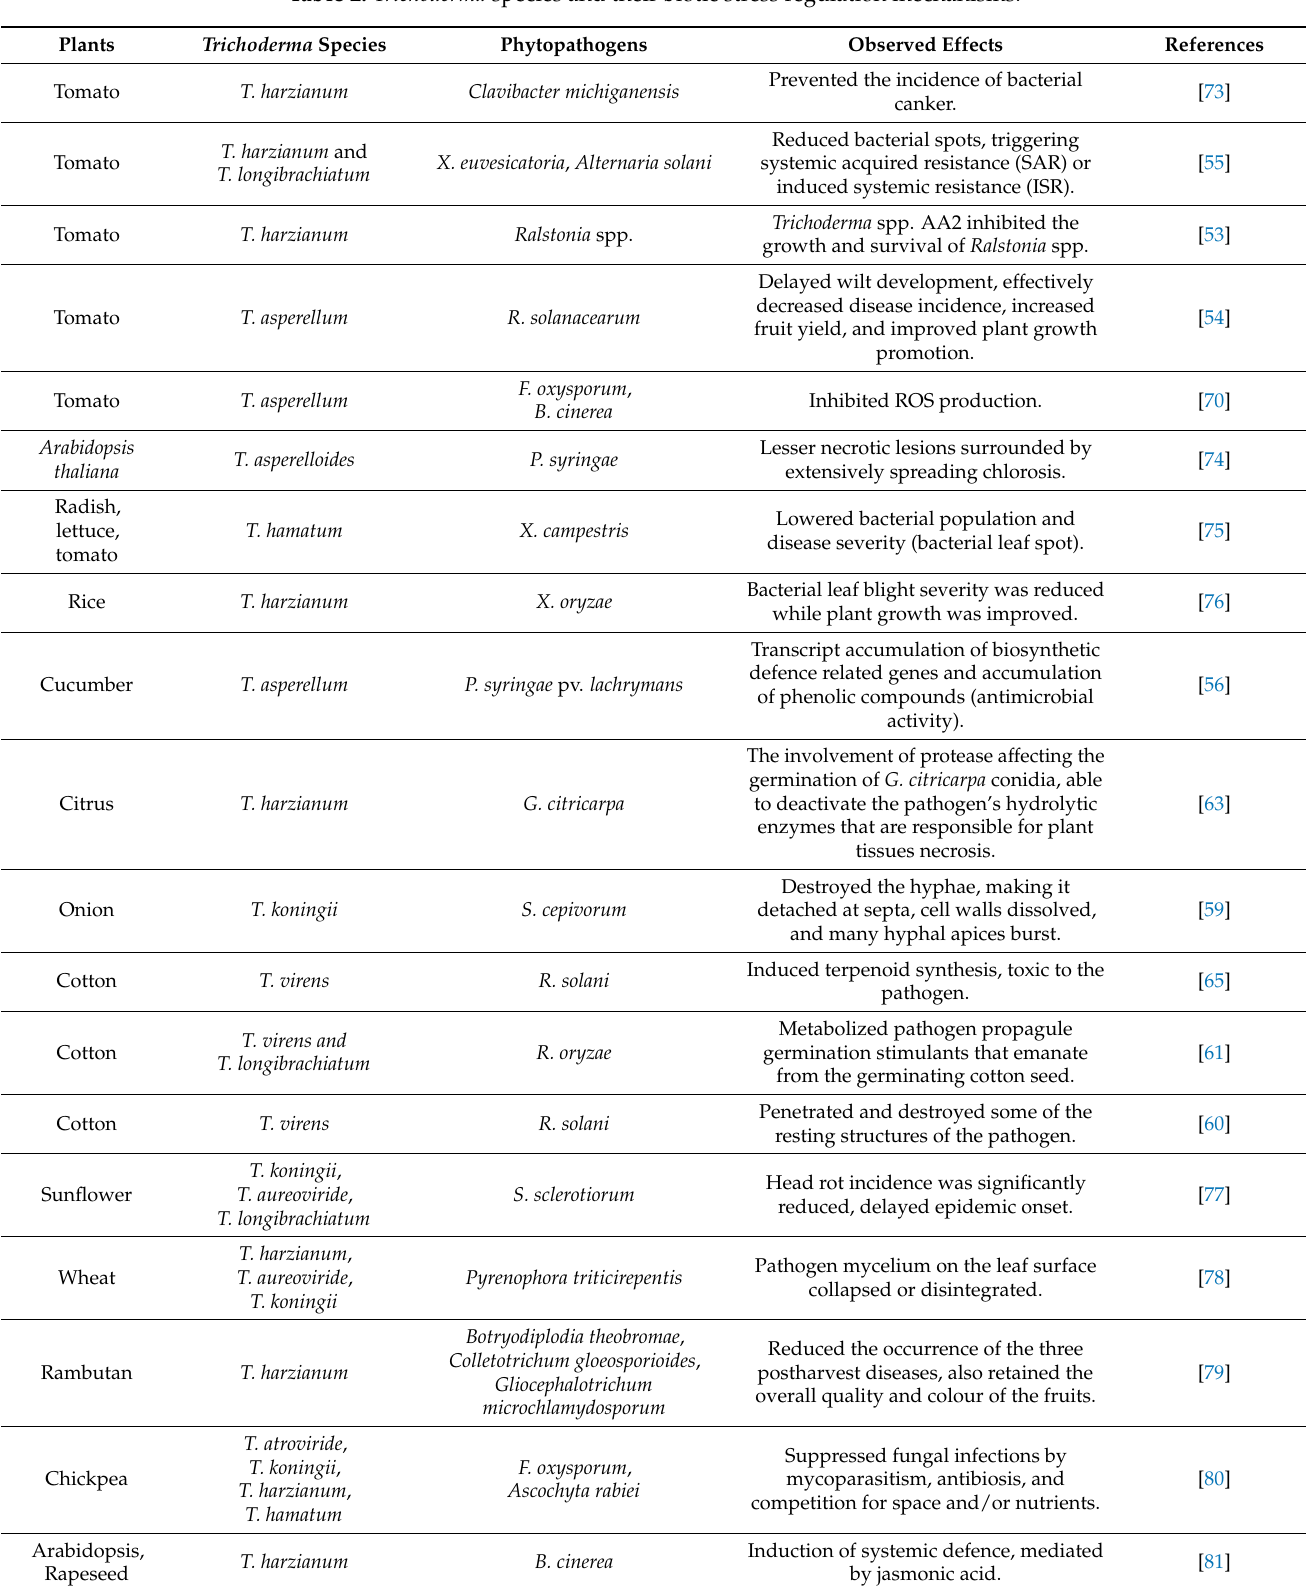
Table 2. Trichoderma species and their biotic stress regulation